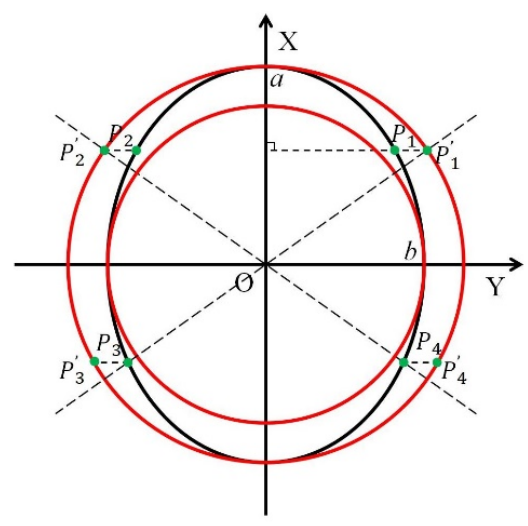
Figure 4. Perspective transformation diagram.